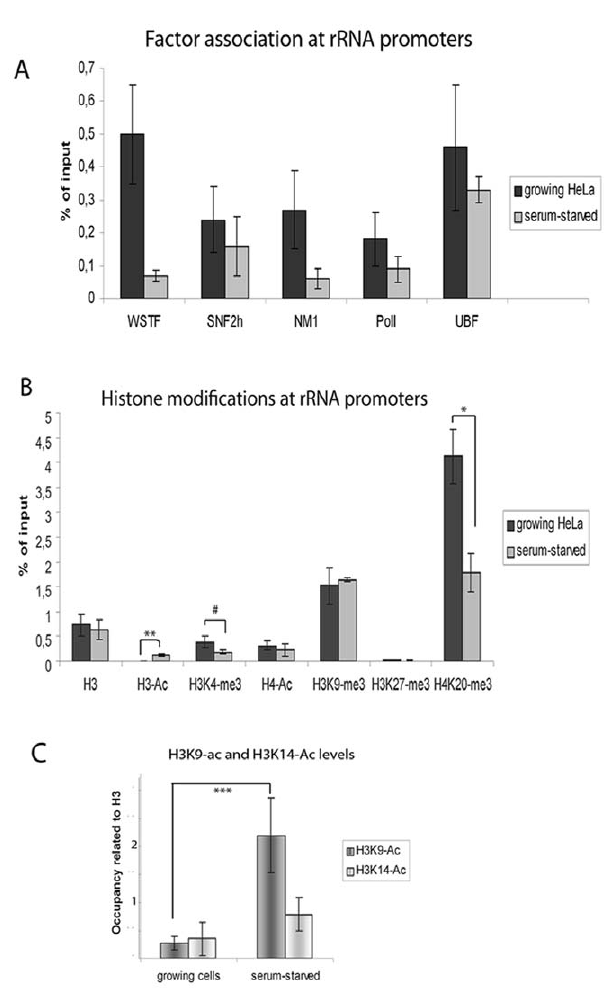
Figure 4. H3-Ac levels are reduced in growing HeLa cells. ( A ) ChIP ofgrowingcellsandserum-starvedcellswithantibodiesasindicatedbelow, detected at the rRNA promoter. The values are presented as the percentages of the input signal for each primer pair. Error bars represent standard deviations from four separate experiments. ( B ) ChIP of growing HeLa cells and serum-starved cells at the rRNA promoters with antibodies indicatedbelowthe bars.Thevalues arepresentedas thepercentage ofthe input signal for each primer pair. Error bars represent standard deviations from six separate experiments. **: p-value=0.0001, *: p-value=0.01, # : p=0.05 (Student t-test, two-sample equal variance). ( C ) ChIP of growing cells and of serum-starved cells using the antibodies indicated detecting the rRNA promoter. The signals have been adjusted to the signal from histone H3 in each experiment. Error bars represent standard deviations from four separate experiments. ***: p-value=0.00036 (Student t-test, two- sample equal variance).